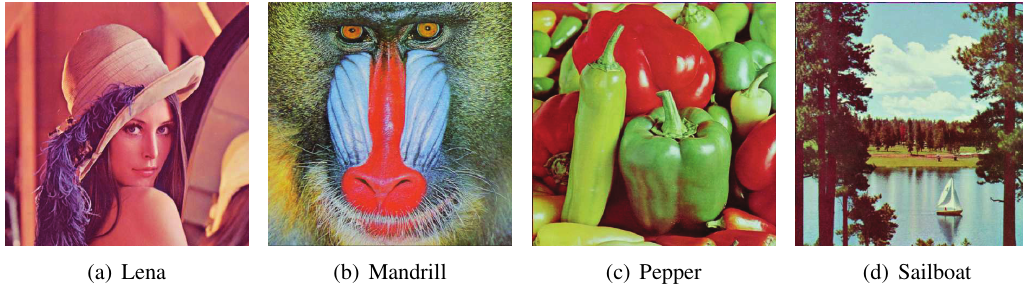
Figure 5: RGB host images. Figure 6. All the considered images have been taken from USC-SIPI image database 30 except RTU logo which is taken from Rajasthan Technical University, Kota, India.